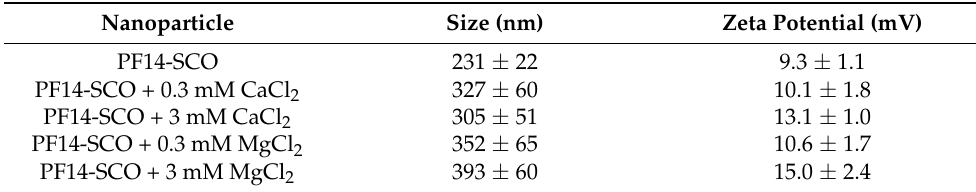
Table 1. The effect of adding calcium and magnesium ions on biophysical characteristics of PF14-SCO nanoparticles. Nanoparticle 10 × water solutions were prepared by mixing 1 µ M SCO and 5 µ M PF14 in MQ water and adding 3 or 30 mM calcium and magnesium 15 min later. The solutions were incubated for total of 30 min at room temperature. For each measurement, nanoparticle 10 × solution was diluted 10-fold by adding a solution containing 1 mM MES buffer and 1 mM NaCl to reach the final volume of 1 mL. Nanoparticle diameter and zeta potential were measured using ZetasizerNano. Each dataset represents mean of at least three independent experiments (performed in triplicates) ± SEM. Data was analyzed by one-way ANOVA with Tukey’s test; no significant differences were